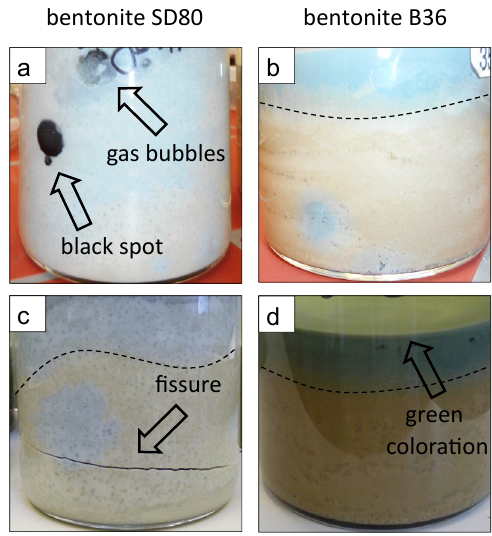
Figure 3. Color changes of both batches (SD80, B36) subjected to Opalinus clay pore water at 25 ◦ C supplemented with substrate. Bentonite SD80 showed ( a ) the occurrence of black spots and gas bubbles after one year and ( c ) a horizontal fissure after two years. Bentonite B36 showed ( b ) a blueish coloration after one year and ( d ) a characteristic green coloration at the bentonite–solution interface after two